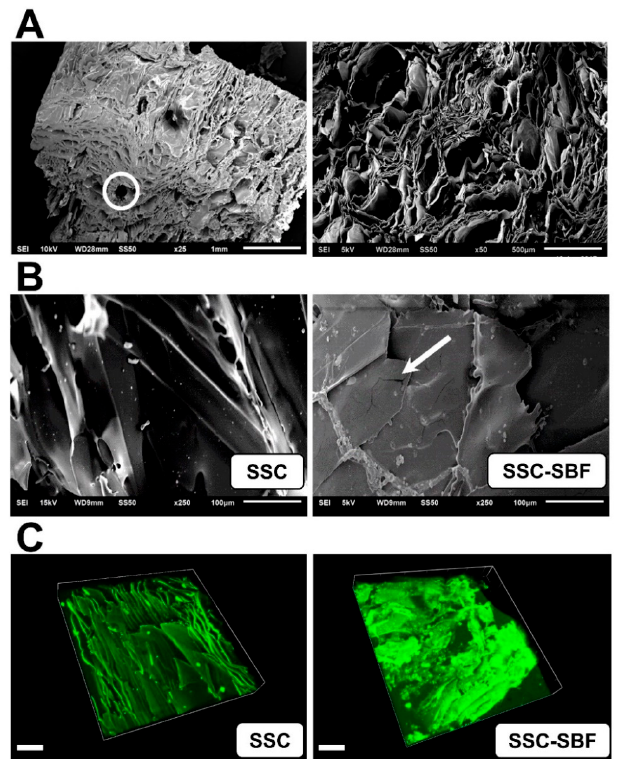
Figure 2. ( A ) Scanning electron micrograph (SEM) showing the highly aligned, unidirectional channel-like pores and transverse interconnecting channels produced by the needle array (white circle); ( B ) SEM image of an untreated silk scaffold (SSC; left image) and a SSC after treatment with 10× simulated body fluid (SSC-SBF; right image), demonstrating a uniform coating of the scaffold with intermittent aggregates and cracks within the coating (arrow). ( C ) Laser scanning confocal microscopy image demonstrating a significant increase in autofluorescence ( ex: 488 nm; em: 518 nm ) after treatment of an SSC with 10× SBF (SSC-SBF), indicating uniform surface mineralization (Scale bar = 100 µm). To evaluate any cytotoxic effects, SSC and SSC-SBF scaffolds were statically seeded with 15000 rat bone marrow-derived mesenchymal stromal cells (rBMSCs) and after 3 days in culture cellular ATP content was measured as a surrogate of cell viability. Further, caspase 3/7 activity was determined to evaluate signs of early apoptosis. ATP content was lower in the mineralized silk scaffolds when compared to the untreated scaffolds (Figure 3A), whereas caspase 3/7 activity was relatively higher in the untreated scaffolds (Figure 3B). However, when calculating the ratio of ATP production to caspase 3/7 activity based on the RLU (relative light units), no difference between the SSC and SSC-SBF scaffolds was obvious (12.20 ± 2.92 vs. 11.40 ± 2.82; p = 0.67, unpaired t -test).